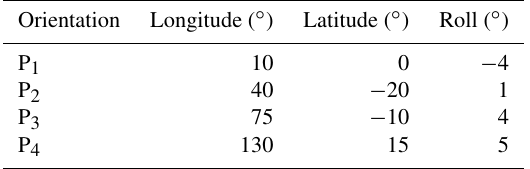
Table 2. Specified coupler orientations for a spherical 4R linkage.